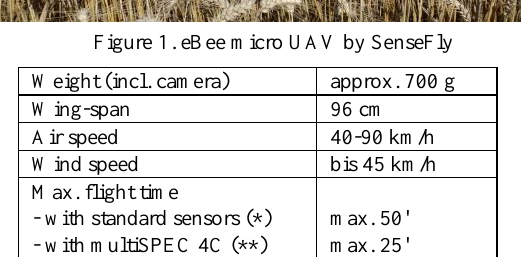
Table 1. Specifications of the eBee UAV.